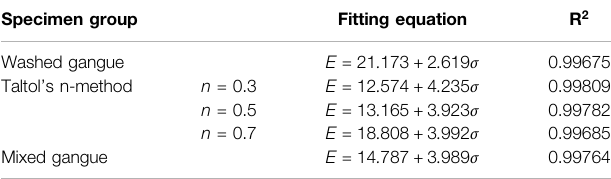
TABLE 12 | Modulus – stress curve table.